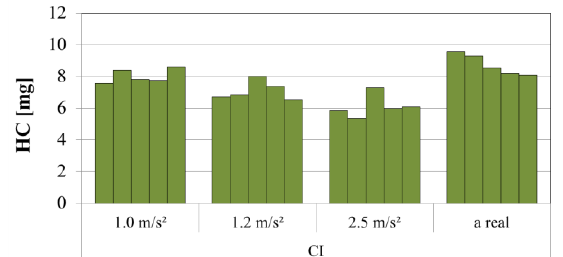
Fig. 16. HC emission for different acceleration characteristics of a vehicle propelled with CI Euro 3 engine obtained during simulation using PTV Vissim software